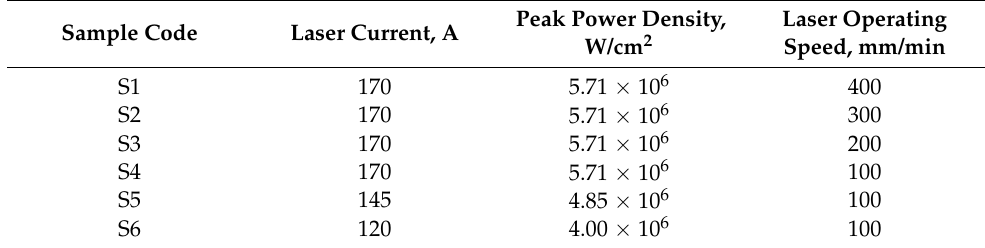
Table 1. Coding of laser-processed